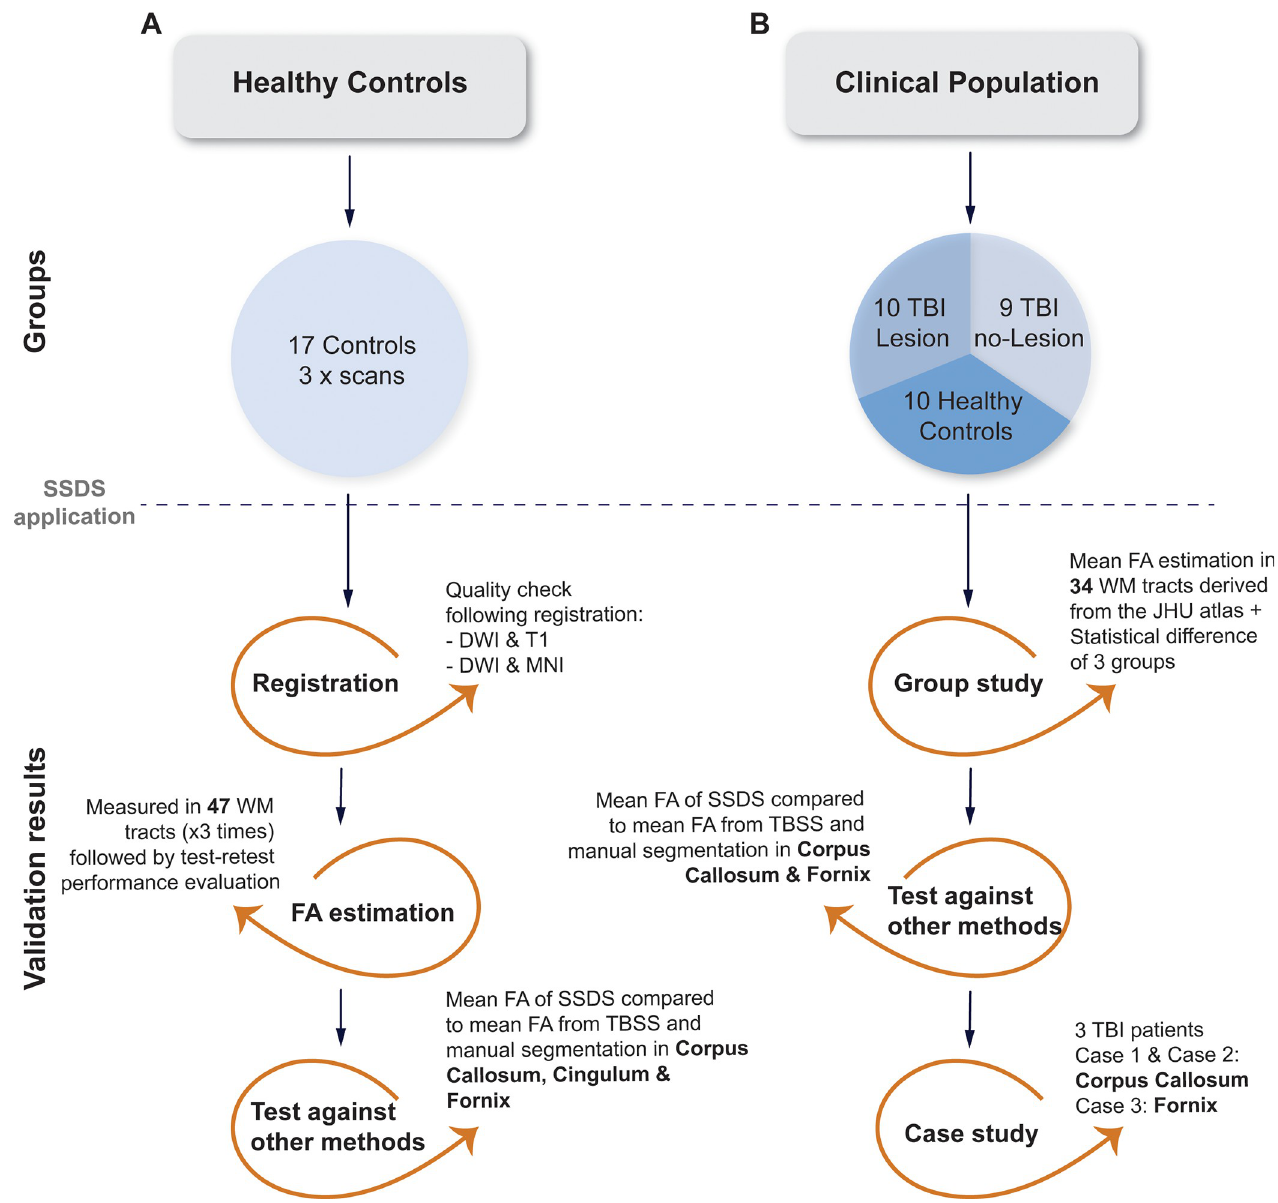
Fig 1. Overview of the validation steps and the results presented in the current study. Analyses on the two cohorts were done separately. The first validations were carried out on the healthy controls (scanned three times for test-retest validation). We present results from the different registration steps, estimation of FA values and test-retest measures, as well as a comparison to other methods. The clinical population (scanned once on the same scanner as the control population) was analyzed first in a group-level study by comparing individually obtained ROI measures, then the results of SSDS were compared to other methods. Finally, three subjects were chosen for case study comparative